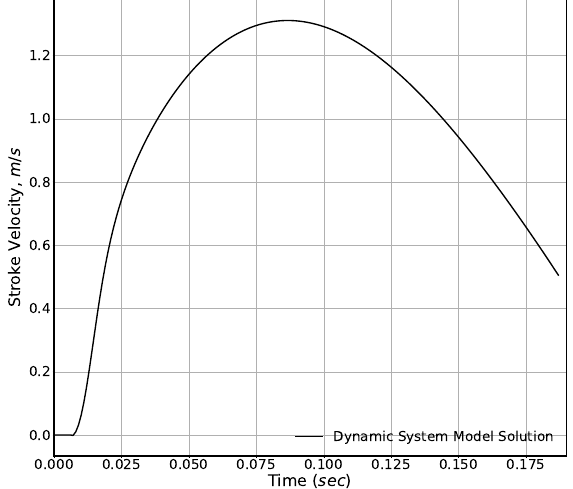
Figure 2. Shock absorber stroke velocity profile from a dynamic system model simulating a drop test used to choose a suitable inlet velocity value in the LES